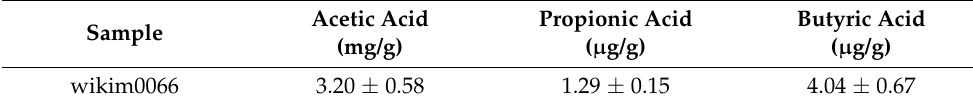
Table 2. Quantitative analysis data of SCFAs in